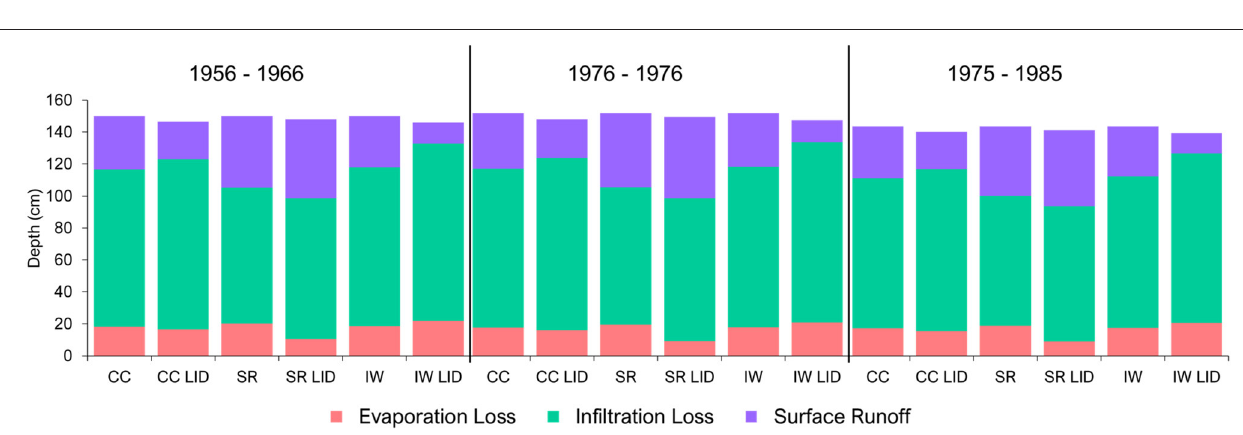
FIGURE 7 | Results of 10-year simulations showing fate of precipitation for each decade modeled. Within all decades, there is an increase in infiltration loss for scenarios with LID features compared to those without LID features (relying on detention ponds only to manage stormwater). In this region, goals for stormwater management include reducing runoff by increasing infiltration and/or increasing evapotranspiration, so scenarios with the lowest runoff represent the desired